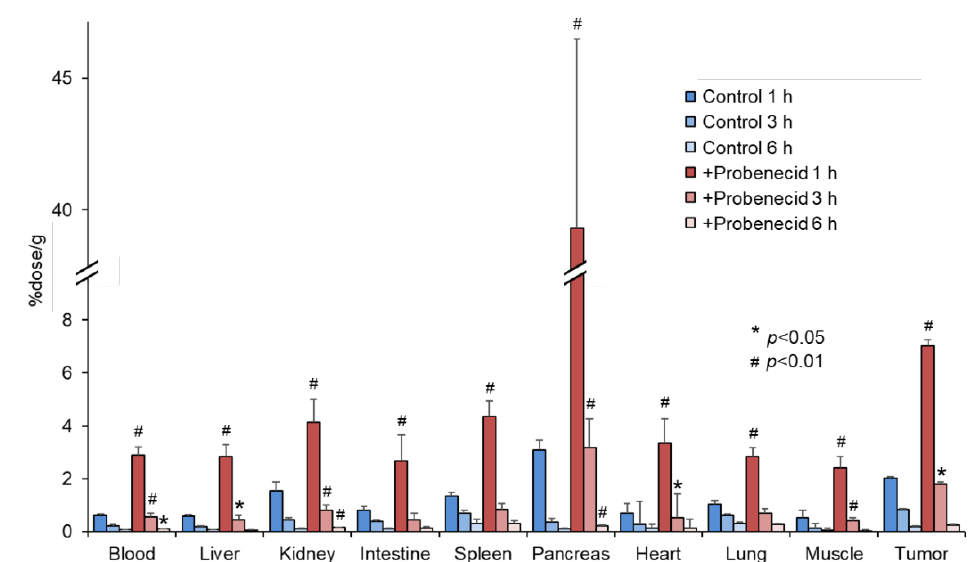
Figure 4. Biodistribution of 2- 211 At-AAMP in tumor-bearing mice with or without intraperitoneal injection of probenecid (mean ± SD, n = 4–5). * p < 0.05 and # p < 0.01 compared with the control group (without probenecid preloading).